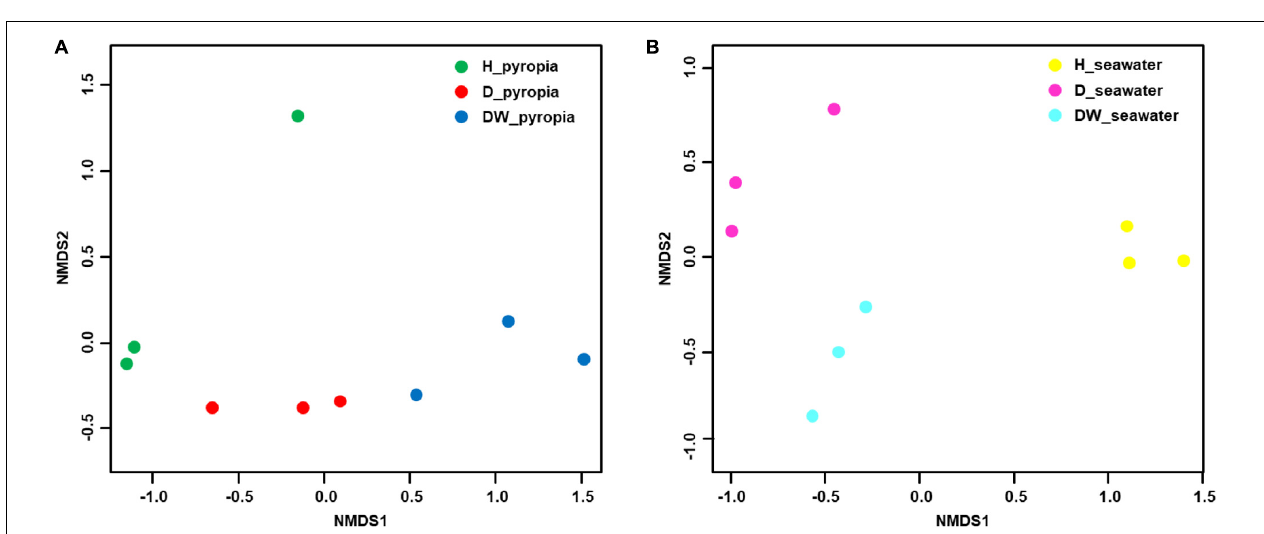
FIGURE 3 | Relationships between individual datasets illustrated by non-metric multi-dimensional scaling (NMDS) ordination. (A) Pyropia yezoensis -associated community datasets. (B) Seawater-associated community datasets.